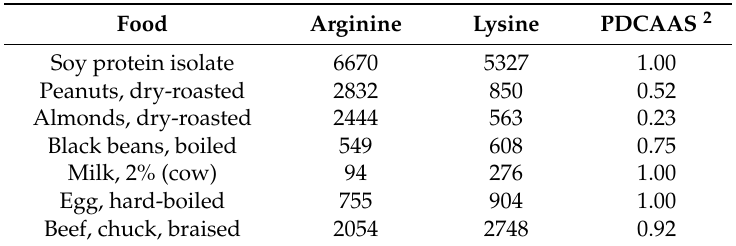
Table 1. Arginine and lysine content 1 of select